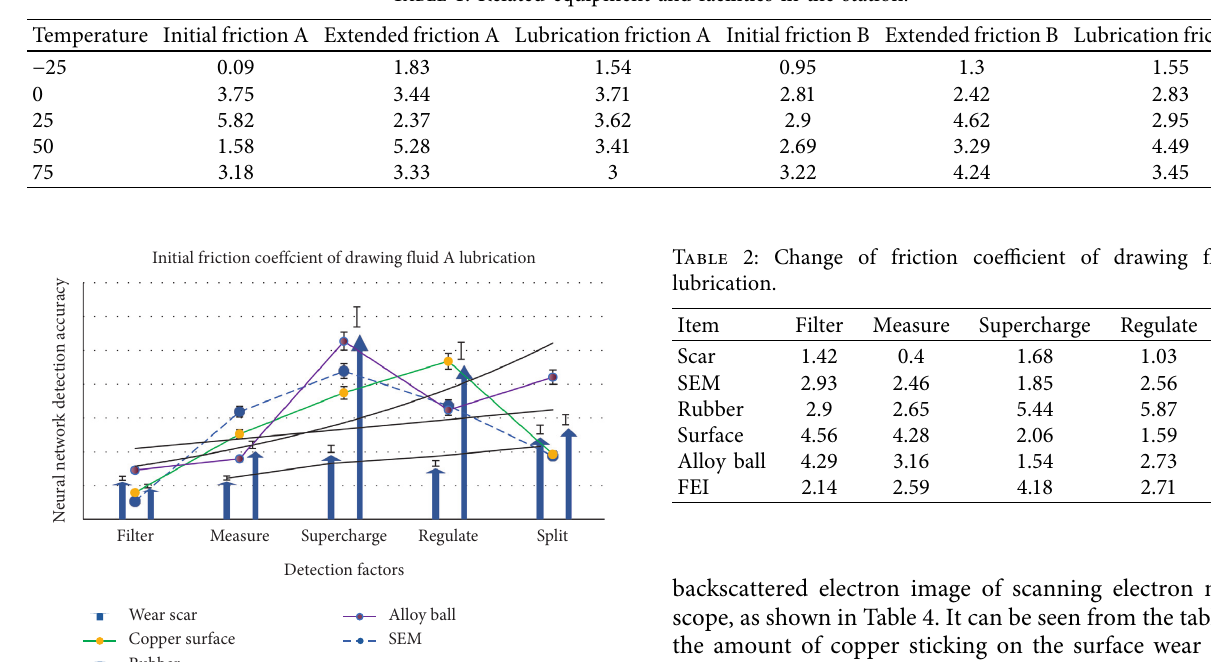
Figure 3: Schematic diagram of dual-circuit liquid supply (from INORA, https://www.inora.com/). Table 1: Related equipment and facilities in the station.